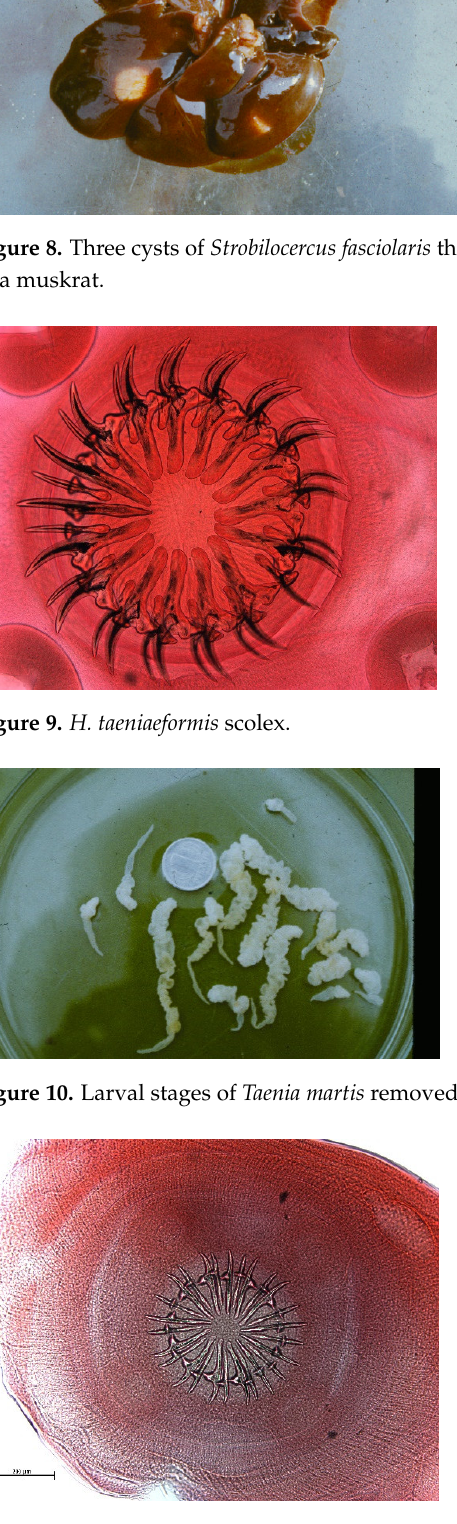
Figure 11. T. martis scolex. Bar: 200 μm.